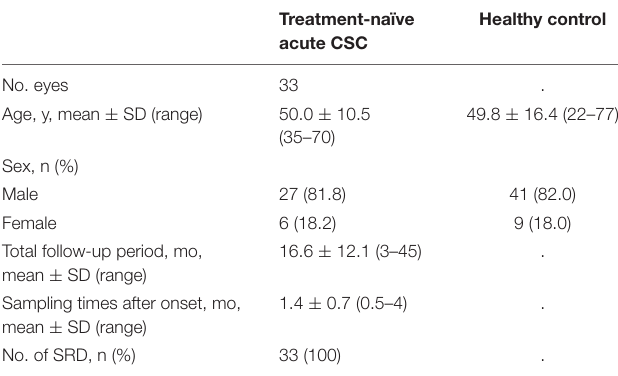
TABLE 1 | Demographic data of treatment-naïve acute CSC patients.